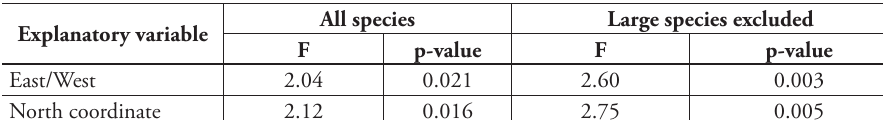
Table 1. Results from tests of the explanatory variables in the CCA-models with all species included and with the largest species (>16 mm in maximum body length) excluded.